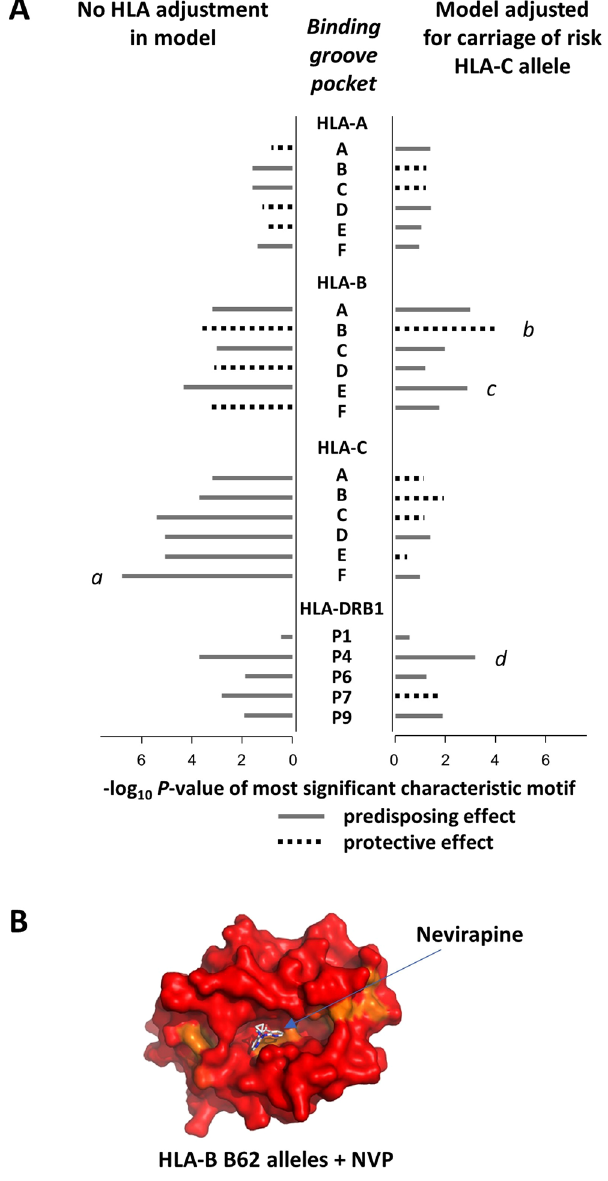
Figure 2. Principal associations with cutaneous NVP HSR across each pocket of the peptide binding groove for HLA-A , -B , -C and - DRB1 . ( A ) Results show the P -value for the characteristic motif having greatest association with cutaneous NVP HSR in ethnicity-adjusted logistic regression analyses with and without additional adjustment for co-carriage of the HLA-C risk F pocket. Alleles sharing the noted characteristic motifs include: ( a ) primary risk alleles HLA-C * 04:01 /03/06, -C * 05:01 , -C * 1801 ; ( b ) protective HLA-B B62 alleles HLA-B * 15:01 /12/24/25/27/32/35 and -B * 52:01 ; ( c ) risk allele HLA-B * 35:05 ; ( d ) HLA-DRB1 risk cluster - DRB1 * 01:01 /02/03 and - DRB1 * 04:04 /05/08/10. ( B ) Molecular docking predictions of NVP binding to protective HLA-B * 15:01. The structure of HLA-B * 15:01 (PDB 1XR8) is colored according to sequence similarity with HLA-B B62 supertype protective alleles. Blosum62 similarity values are: blue, 40–50, cyan, 50–60, green, 60–70, yellow, 70–80, orange 80–90, and red 90–100. Molecular docking predicts that NVP interacts with a structural B pocket largely shared by HLA-B B62 supertype molecules, as indicated with a blue